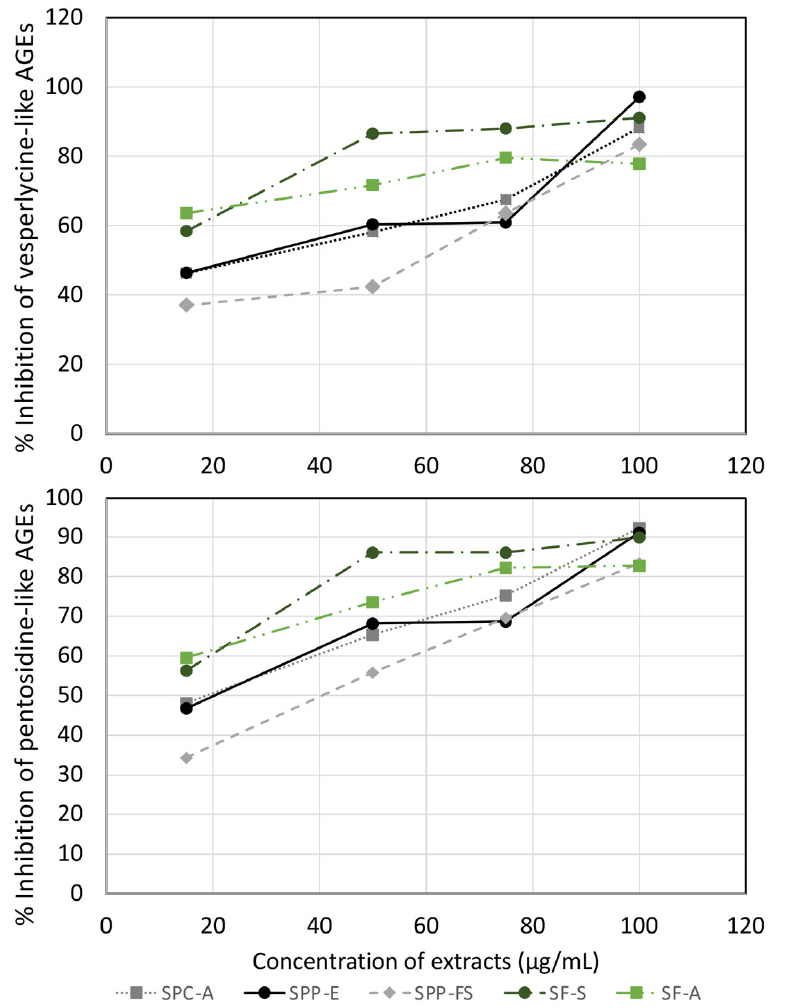
Figure 3. The % inhibition of pentosidine-like and vesperlycine-like AGEs by the hydroalcoholic extracts of Salvia leaf samples in a concentration range of 15 to 100 μg/mL.